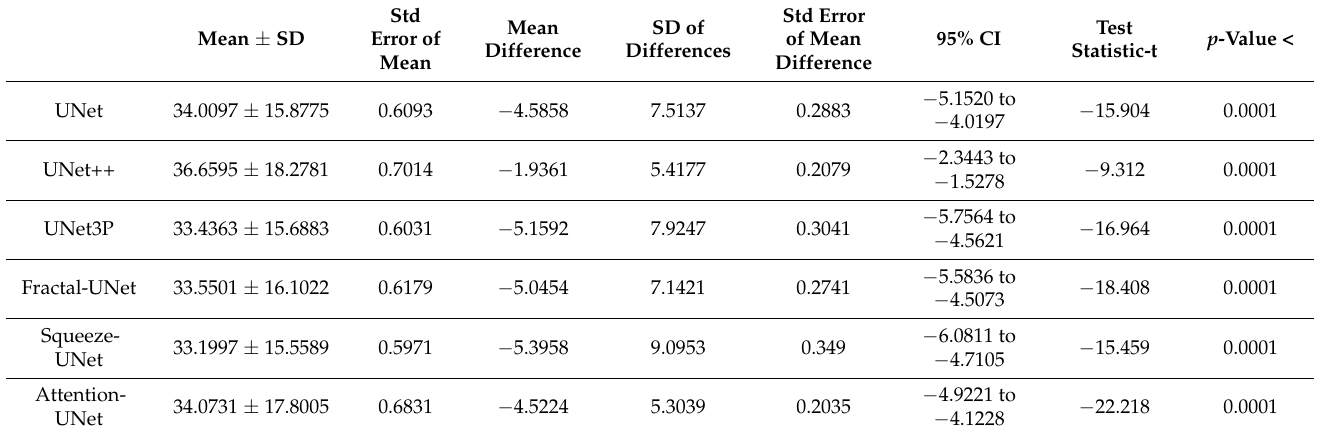
Figure 15. Paired samples t -test Plot for all 6 types of UNet models for CCA DB2A database. Table 7. Paired- t -test metrics for GTPA and estimated area by all UNet models for CCA